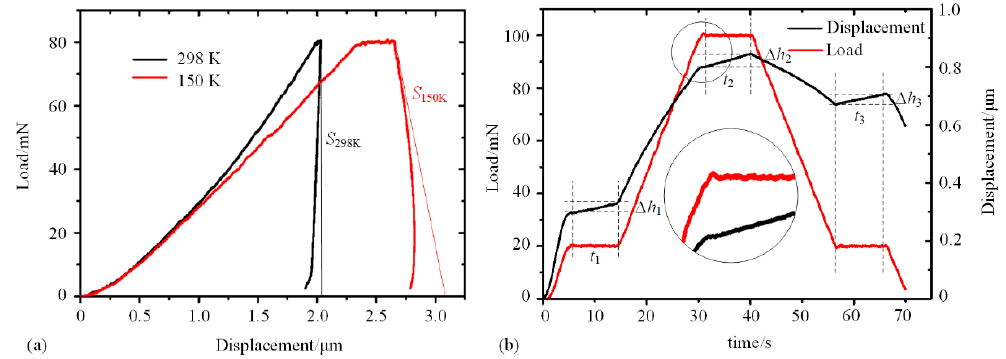
Figure 12. Indentation curves with contact drift. ( a ) P-h curve at RT and low temperature. ( b ) h-t curve and P-t curve with contact drift.